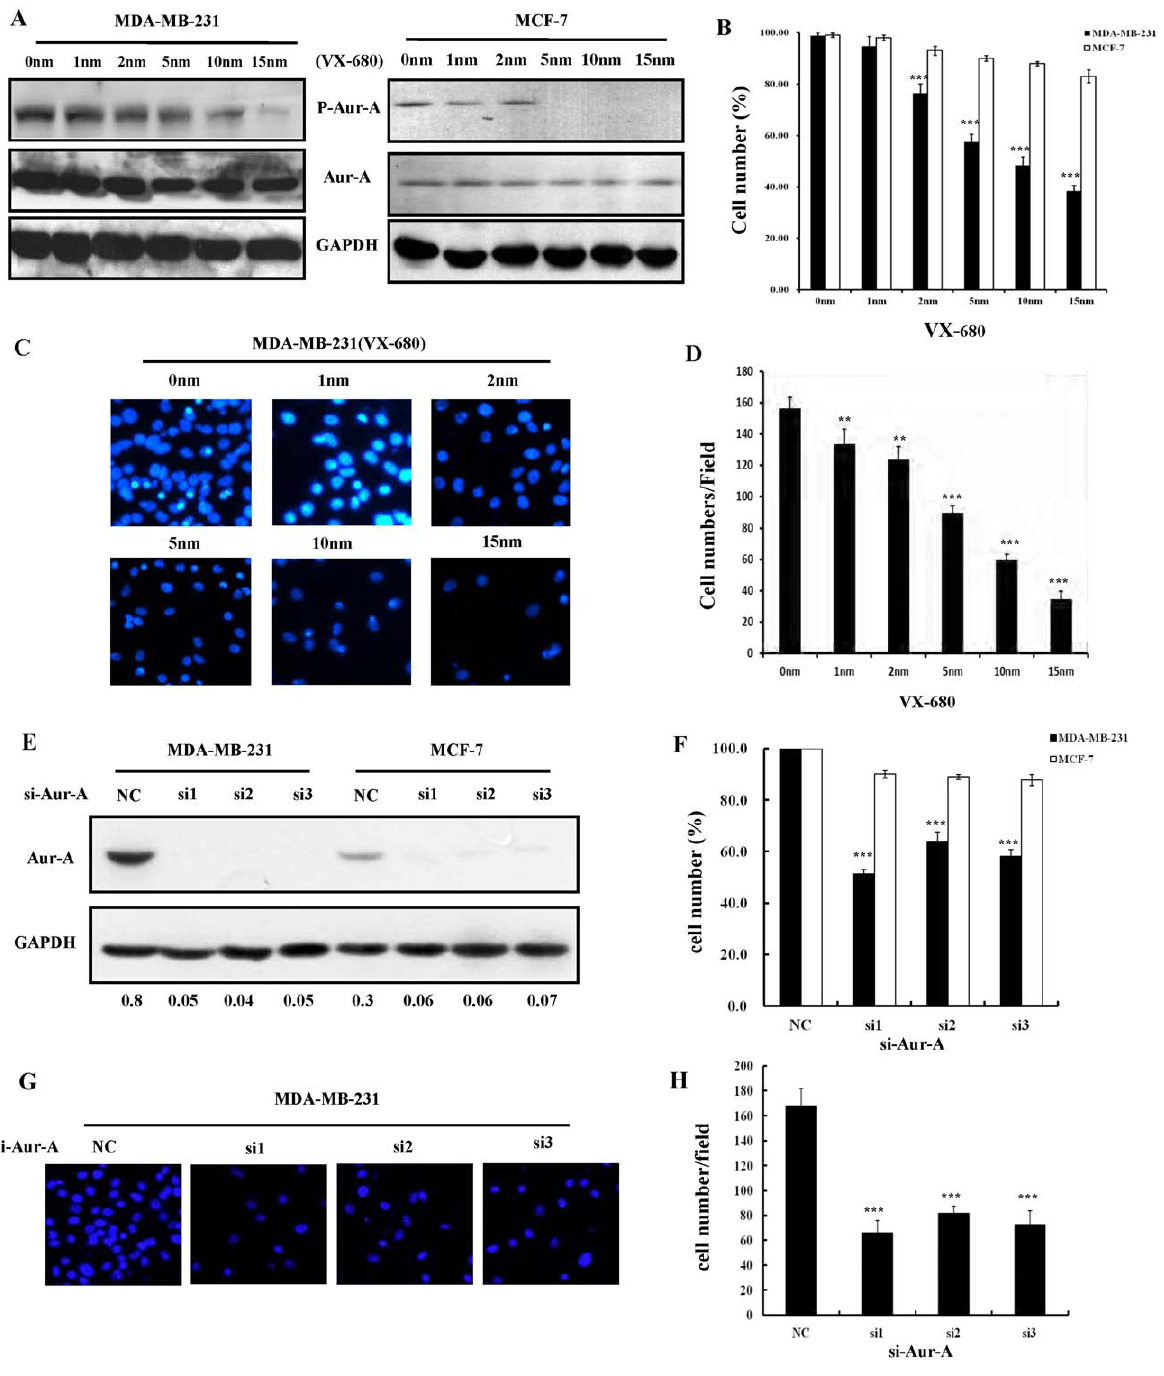
Figure 5. Inhibition of Aur-A kinase inhibited TNBC cell proliferation and reduced cell migration. (A) TNBC cell MDA-MB-231 and non- TNBC cell MCF-7 were incubated with indicated doses of VX-680 (1, 2, 5, 10, and 15 nm), or DMSO for 24 h; Cells were harvested, and subjected to Western blot analysis for the indicated proteins. (B) MDA-MB-231 and MCF-7 cells were exposed to different concentrations of VX-680 (1, 2, 5, 10, and 15 nm) or DMSO for 24 h. Cell survival rates were measured by MTT assay, * P , 0.05; ** P , 0.01; *** P , 0.001. (C) and (D) MDA-MB-231 cells were seeded for transwell migration assay in the presence of DMSO or increasing doses of VX-680. After incubation for 24 h, migration rates were quantified by counting the migrated cells in five random fields. Original magnification, 100 6 . Data summarized three independent experiments. Columns, average cell number; bars, SD. (E) TNBC cell MDA-MB-231 and non-TNBC cell MCF-7 were treated with targeted RNAis or control for 48 h, then cells were harvested, and subjected to Western blot analysis for the indicated proteins. (F) MDA-MB-231 and MCF-7 cells were treated with different RNAis for 48 h. Cell survival rates were then measured by MTT assay. (G) and (H) MDA-MB-231 cells were treated with different RNAis for 24 h, then seeded for transwell migration assay for 24 h, migration rates were quantified by counting the migrated cells in five random fields. Original magnification, 100 6 .